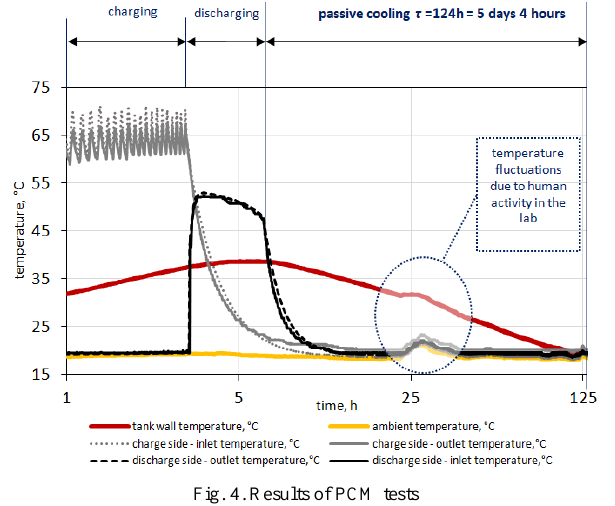
Fig. 4. Results of PCM tests